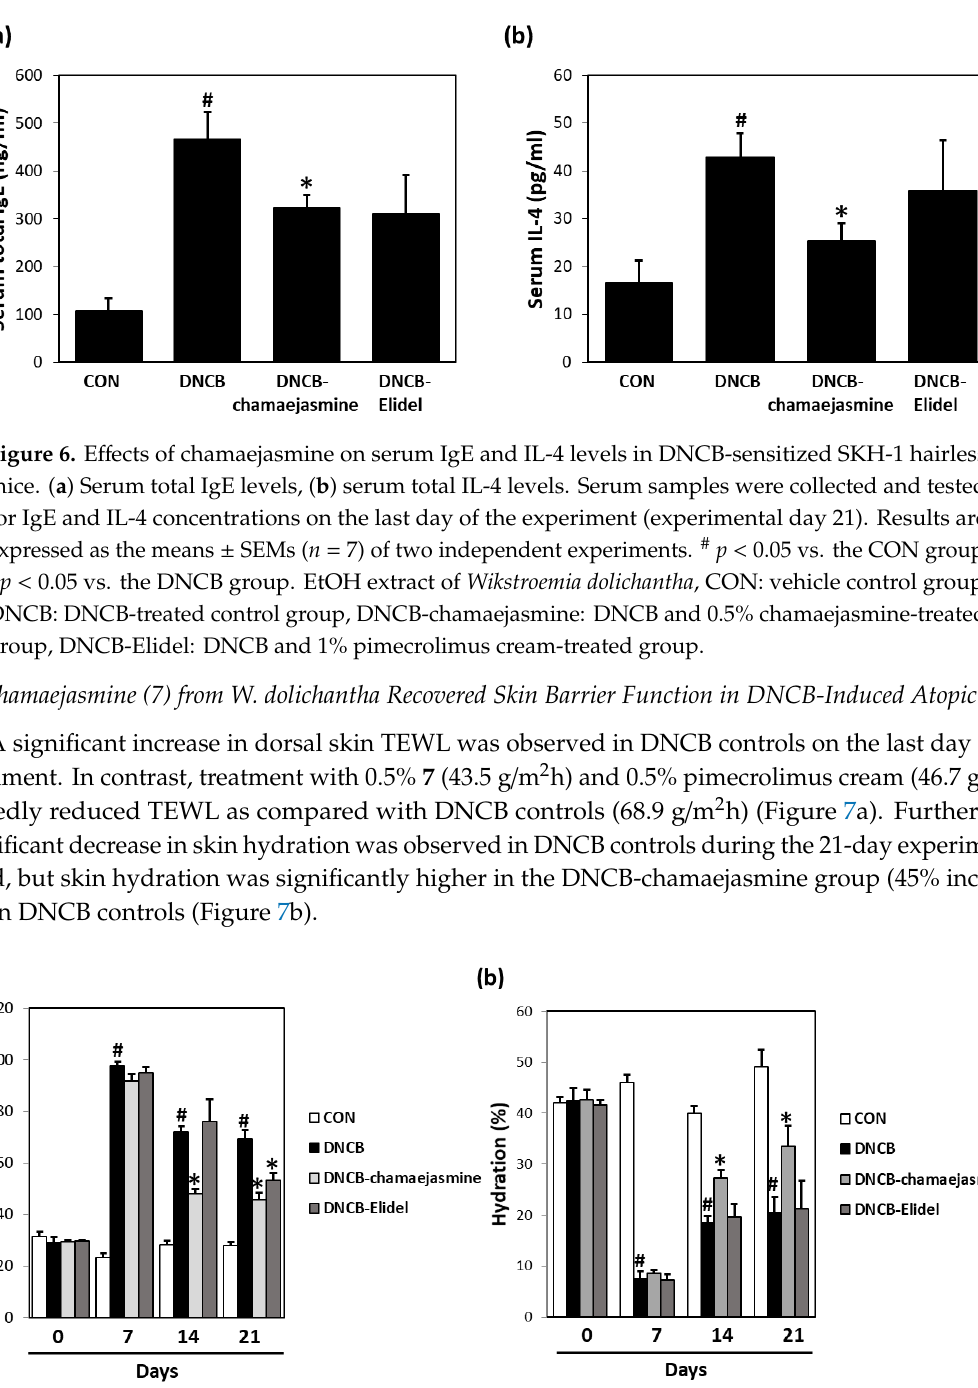
13 of 12 Figure 5. Effects of chamaejasmine on histopathological changes, epidermal thicknesses, and mast cell numbers in DNCB-induced AD-like skin lesions in SKH-1 hairless mice. ( A ) H&E staining, ( B ) toluidine blue staining, ( C ) epidermal thicknesses and ( D ) mast cell numbers. Results are expressed as the means ± SEMs of two independent experiments. # P < 0.05 vs. the CON group; * P < 0.05 vs. the DNCB group. CON: vehicle control group, DNCB: DNCB-treated control group, DNCB- chamaejasmine: DNCB and 0.5% chamaejasmine-treated group, DNCB-Elidel: DNCB and 1% pimecrolimus cream-treated group. 3.3. Chamaejasmine (7) Reduced Serum IgE and IL-4 Levels in DNCB-Induced Atopic Mice The major biochemical characteristics of AD are increased serum levels of IgE and IL-4. Serum IgE levels were significantly higher in DNCB controls than in untreated controls. Treatment with 0.5% 7 resulted in a 38% decrease in serum IgE concentration versus DNCB controls (Figure 6A).